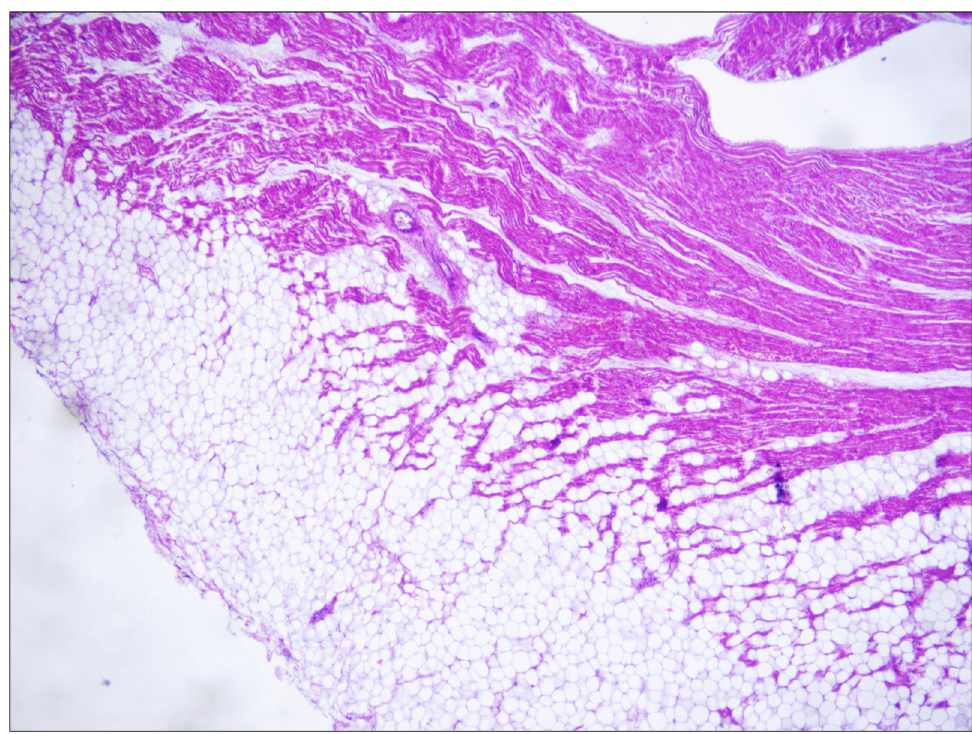
Figure 2. Histopathological examination (hematoxylin and eosin) of the sino-atrial node shows in- terstitial fibrosis and eosinophilic inflammatory infiltrate: ( A ) 4× magnification; ( B ) 10× magnifica- tion; ( C ) 20× magnification; ( D ) 40× magnification.